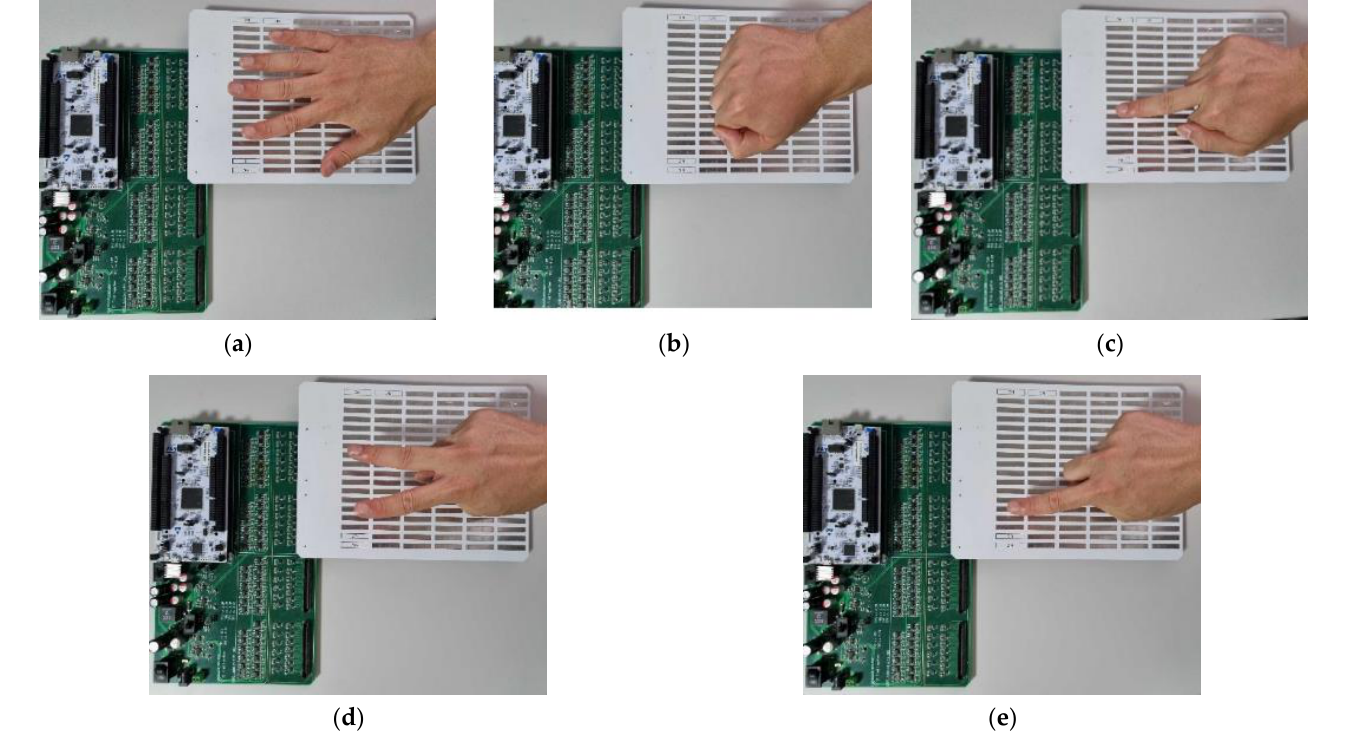
Figure 7. The five hand gestures used in our work: ( a ) Palm, ( b ) Fist, ( c ) Middle, ( d ) OK, and ( e ) Index.